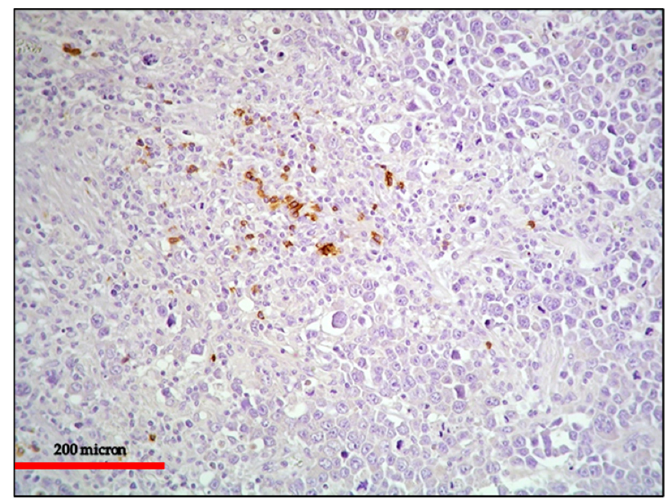
Figure 6. EC-PEL of the ileum: in this case, the neoplastic proliferation lacks B-cell marker expression; this is often a common feature of neoplasms with plasma cell differentiation such as PBL and PEL (CD20 immunostaining, Ventana immunostainer, magnification 200×; original image from Prof Ascani).